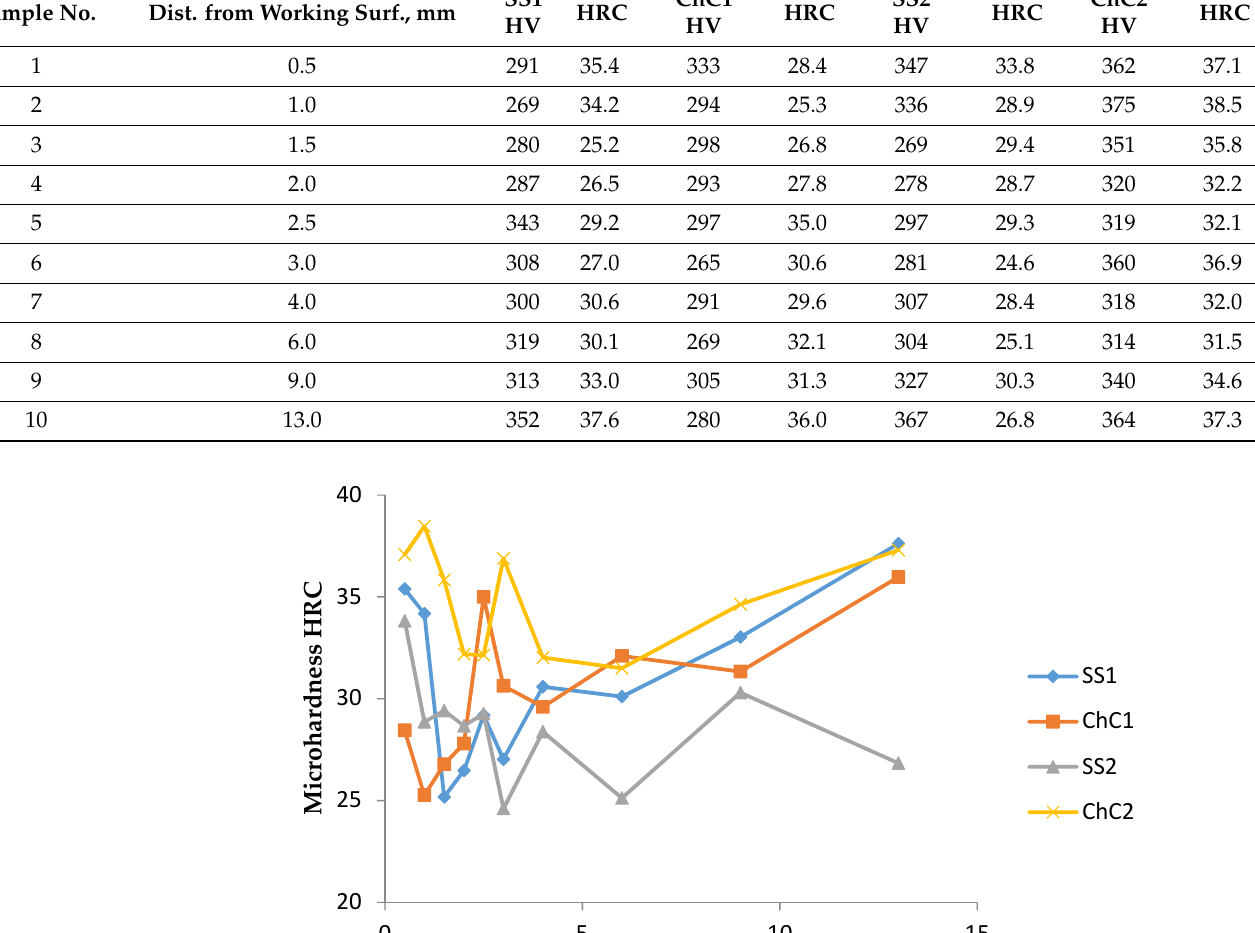
Table 6. Vickers microhardness values—measured in HV0.5 scale and converted to HRC according to Qvarsnstöm method [51]. Sample No. Dist. from Working Surf., mm